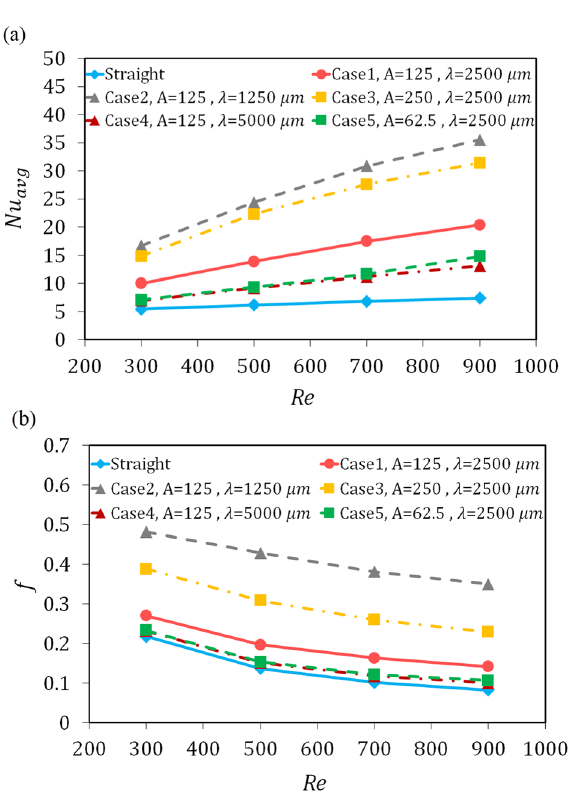
Figure 7. Comparison for ( a ) the average Nusselt number, and ( b ) friction factor versus the Reynolds